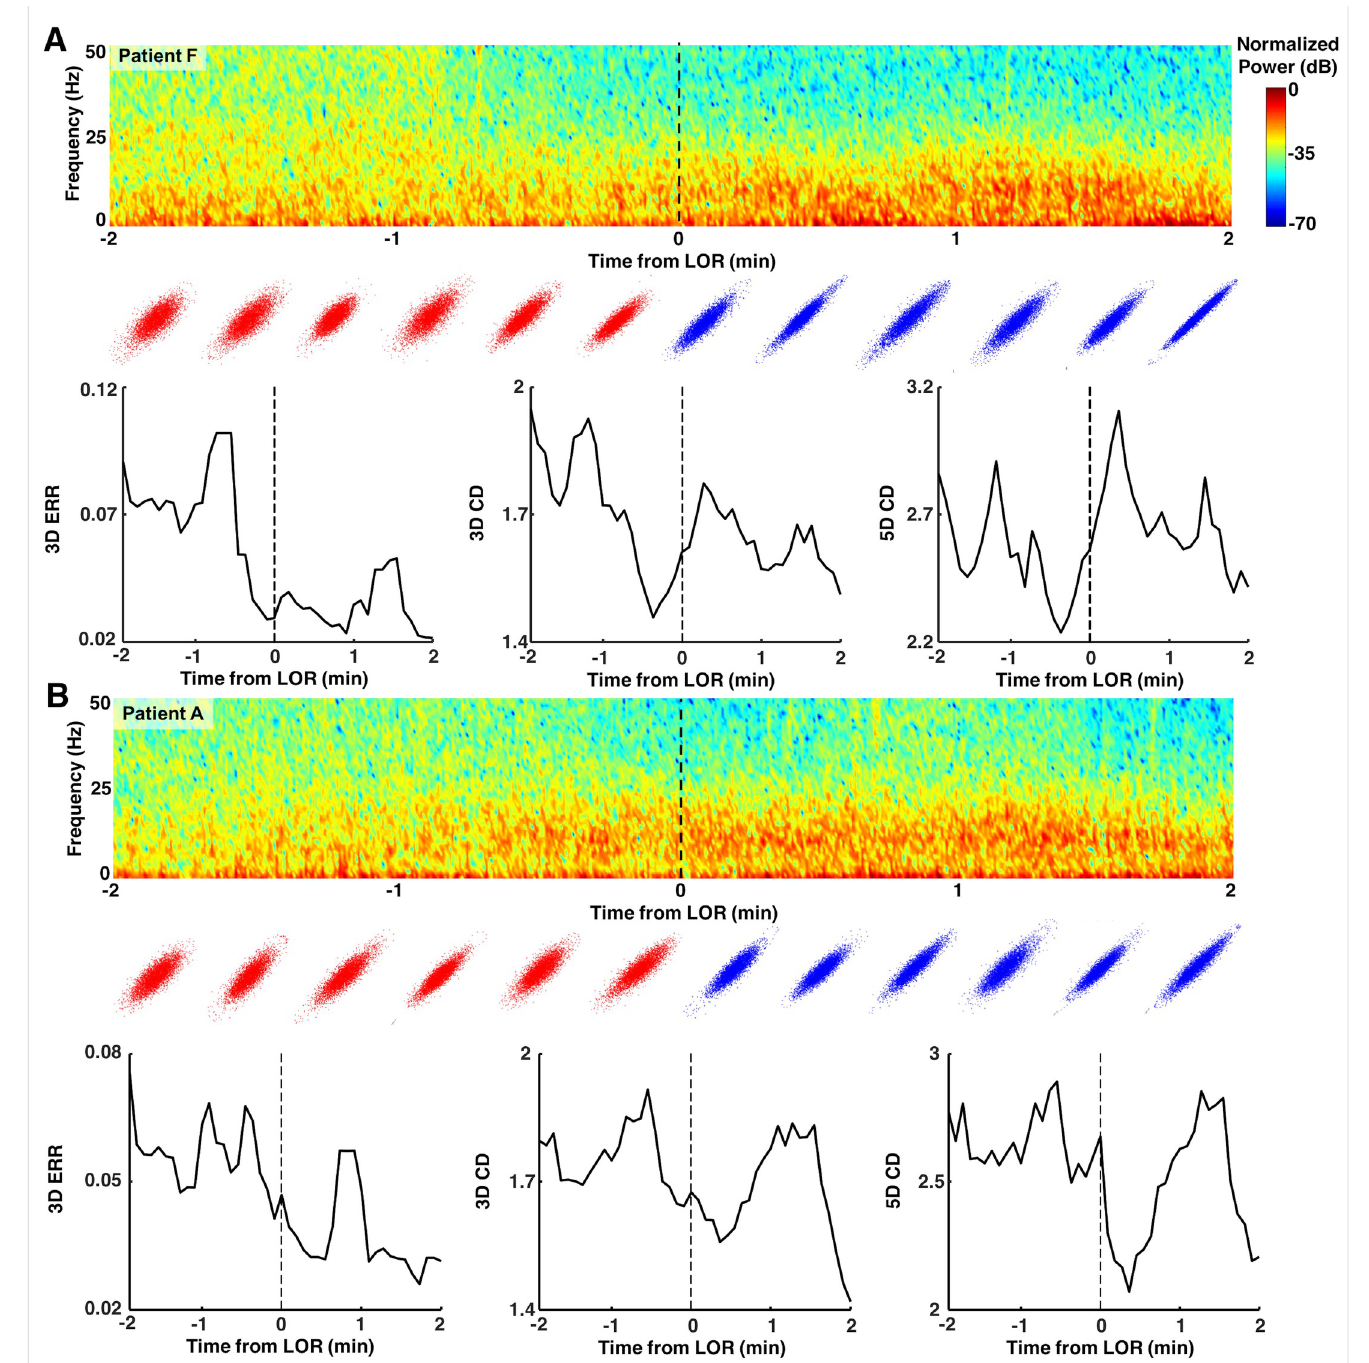
Fig 9. Examples of dynamics of attractors around loss of response (LOR). Spectrograms and attractors for epochs surrounding LOR by +/- two minutes for two individual patients ( A and B ). Attractors are three-dimensional but shown projected into two dimensions from the same viewing angle. Note the flattening and more ellipsoidal shapes approaching and following LOR in both patients. The ellipse radius ratio (ERR) measure appears to be the only one to decrease throughout the LOR period.